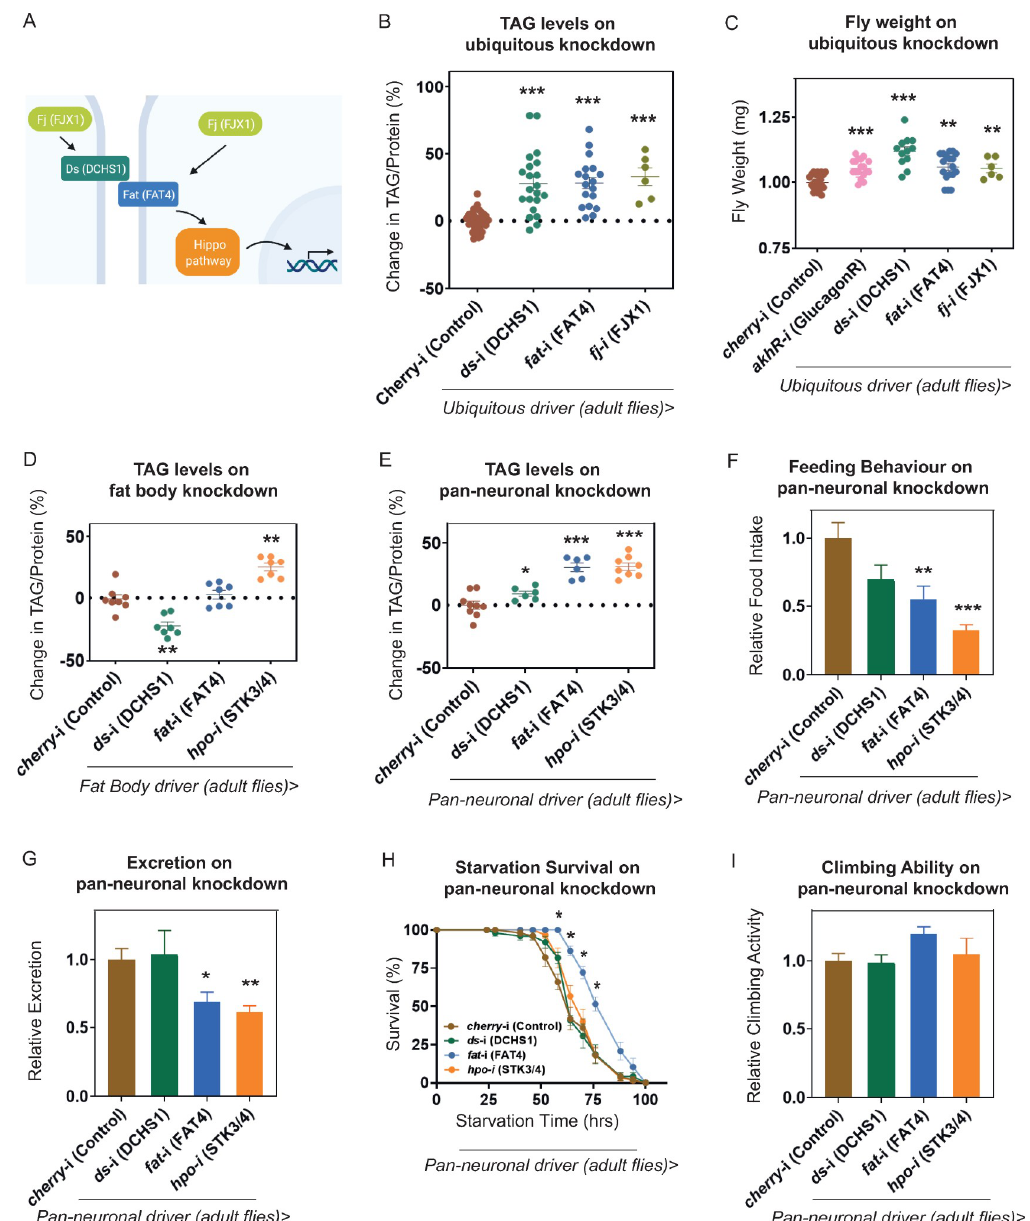
Fig 3. Dachsous, Fat, Four-jointed, and Hippo regulate Drosophila obesity. (A) A schematic of Dachsous and Fat signalling pathways. (B) TAG levels normalised to level of protein upon ubiquitous knockdown of Drosophila dachsous , fat , or fj in adult flies. Each data point corresponds to an average of 3 technical replicates of TAG normalised to protein levels obtained from 10 male flies. Results obtained from multiple replicates are shown for knockdown of both genes. (C) Fly weight upon ubiquitous knockdown of Drosophila dachsous , fat , or fj . Each data point corresponds to the weight of 8 to 10 males normalised to number of flies. TAG levels normalised to level of protein in adult male flies upon adult specific (D) fat body and (E) pan-neuronal knockdown of dachsous , fat , and hpo . Adult-specific pan-neuronal knockdown of ds , fat , or hpo decreases food intake and excretion on fat and hpo knockdown (F, G), increases survival upon starvation after fat knockdown (H), and does not affect climbing ability (I). Results obtained from multiple replicates are shown for all genes. Error bars represent SEM; � p < 0.05, �� p < 0.01 and ��� p < 0.001 versus control by Mann–Whitney U Test. The underlying data for this figure can be found in S7 Table. Fig 3A was “created with BioRender.com.” TAG,